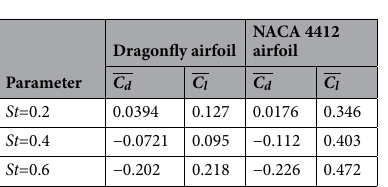
Figure 15. The C d and C l of NACA 4412 airfoil in different St at Re = 5 × 10